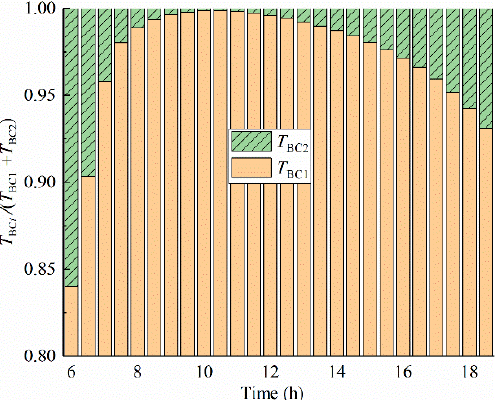
Figure 18. Hourly percentages of components T BC1 and T BC2 at the top surface.